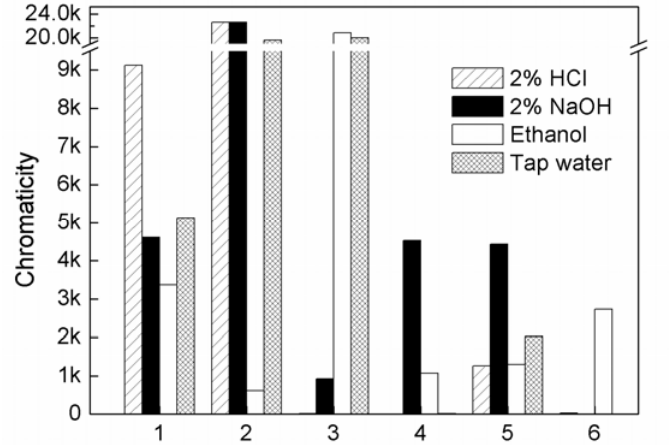
Figure 9. Color release of APRB ( 1 ), MB ( 2 ), ABB6B ( 3 ), the CaCO BaSO -MB ( 5 ) and Ca 4 ethanol and tap